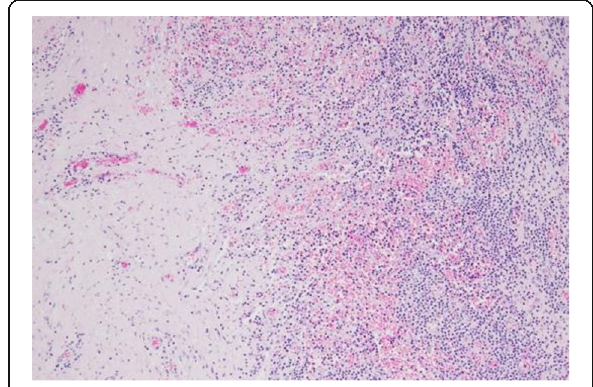
Fig. 6 Histopathological diagnosis of the surgical specimen. Neutrophil-based inflammatory cell infiltration and inflammatory granulation of the